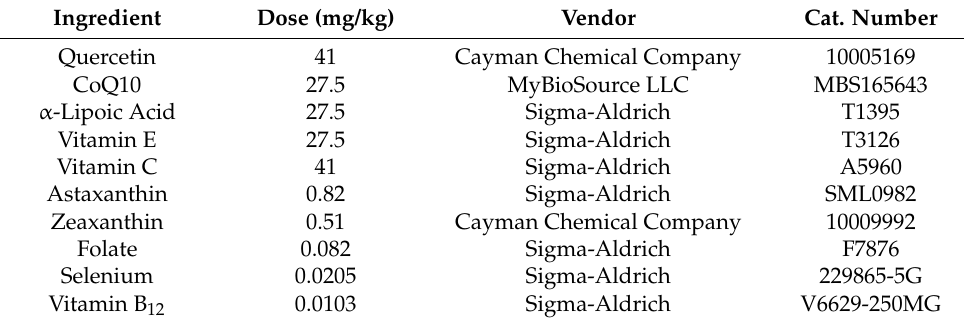
Table 1. Multi-ingredient antioxidant supplement